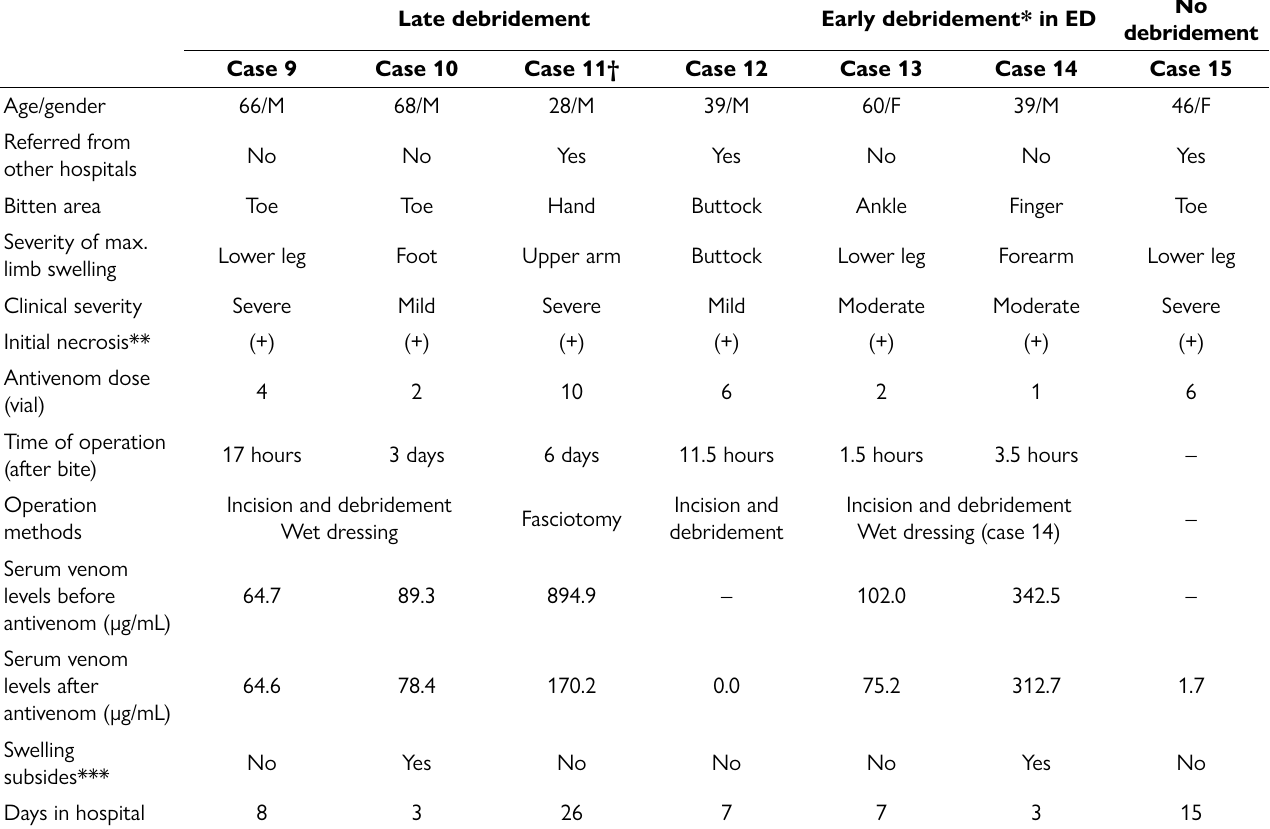
Table 3. Clinical characteristics of the wound necrosis group.